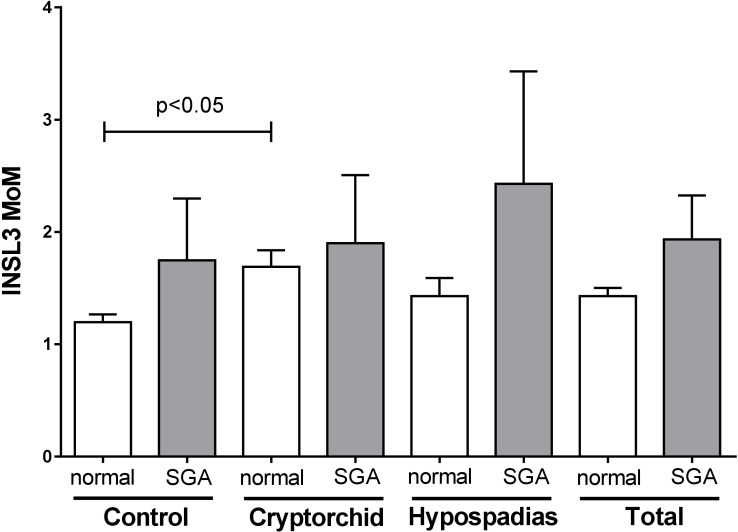
Age-corrected INSL3 MoM values for all gestational weeks combined for cases and controls, separately and together (total), separated into pregnancies calculated to be SGA and normal pregnancies (not SGA). Only the difference between non-SGA controls and cryptorchids was considered significantly different.